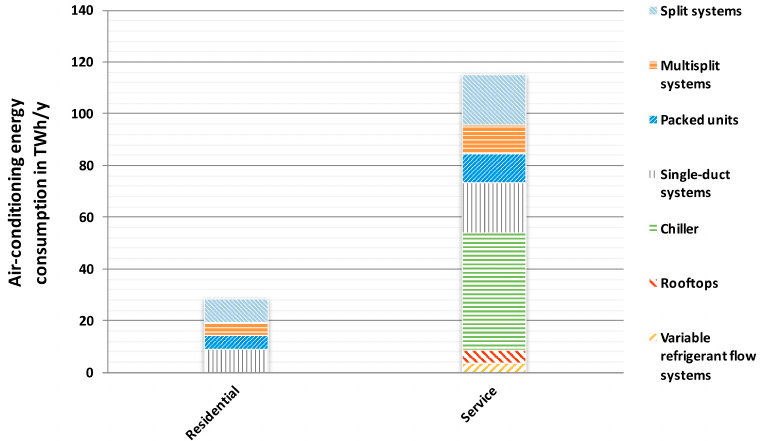
Figure 3. AC energy consumption per type, residential and service sectors, EU28 (see references in